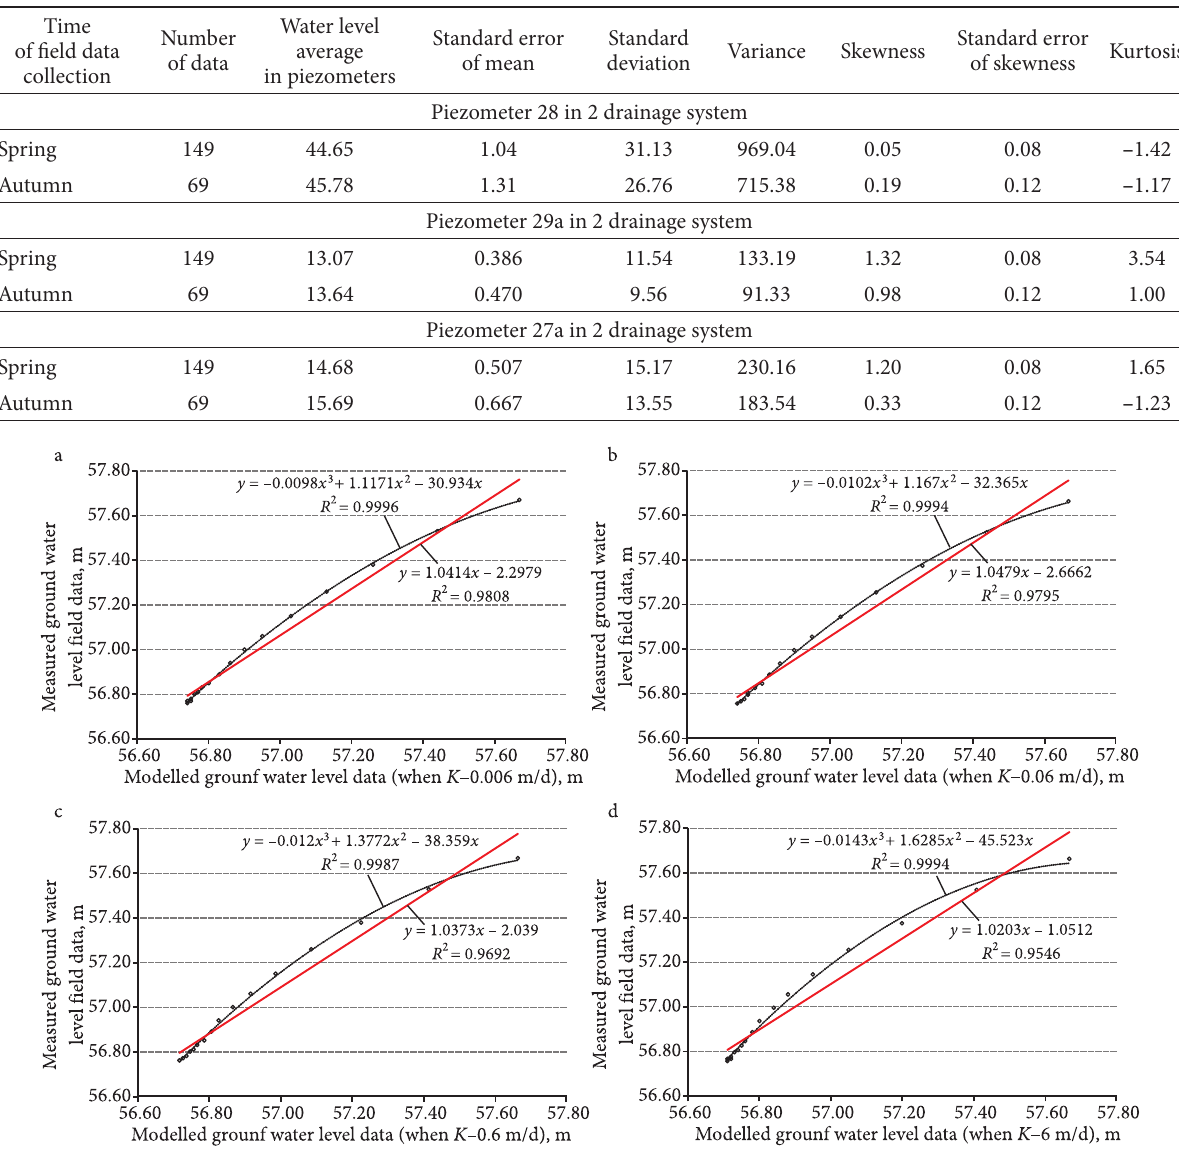
Table. 1. Descriptive statistics of measured field data in Pikeliai experimental site (1999–2005)